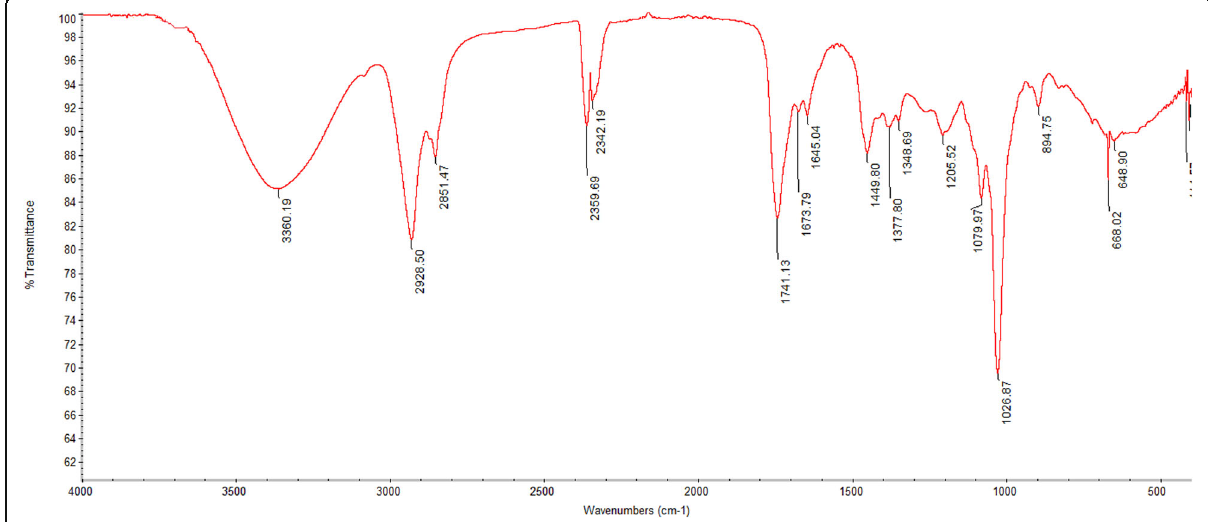
Fig. 3 FTIR spectrum of methanolic extract of Andrographis paniculata whole